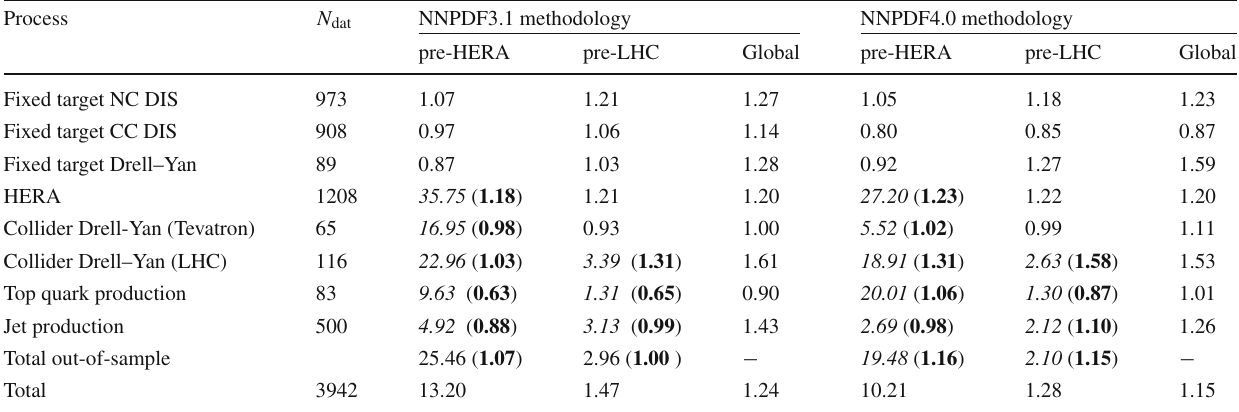
Table28 Valuesofthe χ 2 perdatapointforthetotaldatasetandforspe- cific process types obtained for NNPDF4.0 and for the pre-HERA and pre-LHC future test PDFs, determined using NNPDF3.1 or NNPDF4.0 methodology. All the data in each process type are either fully included or fully excluded from each PDF determination. Values in regular font correspond to fitted datasets, evaluated with the experimental covari-